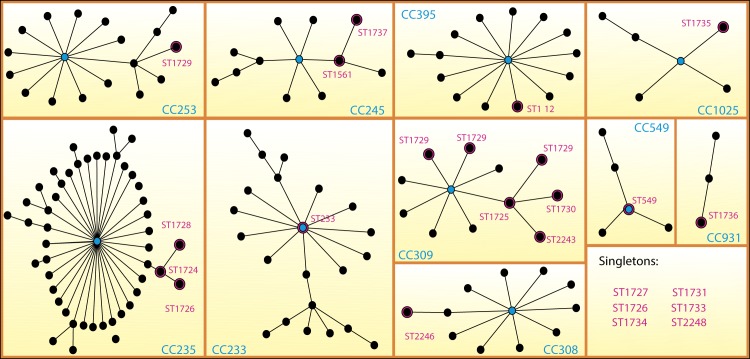
Diagram of clonal complexes of Pseudomonas aeruginosa strains produced with the eBURST v3 algorithm.P. aeruginosa isolates (n = 59 ST). Black points represent sequence types (STs); lines connect single-locus variants (SLVs) or double-locus variants (DLVs). The STs with pink halos were described in this study. Blue points represent founder STs.